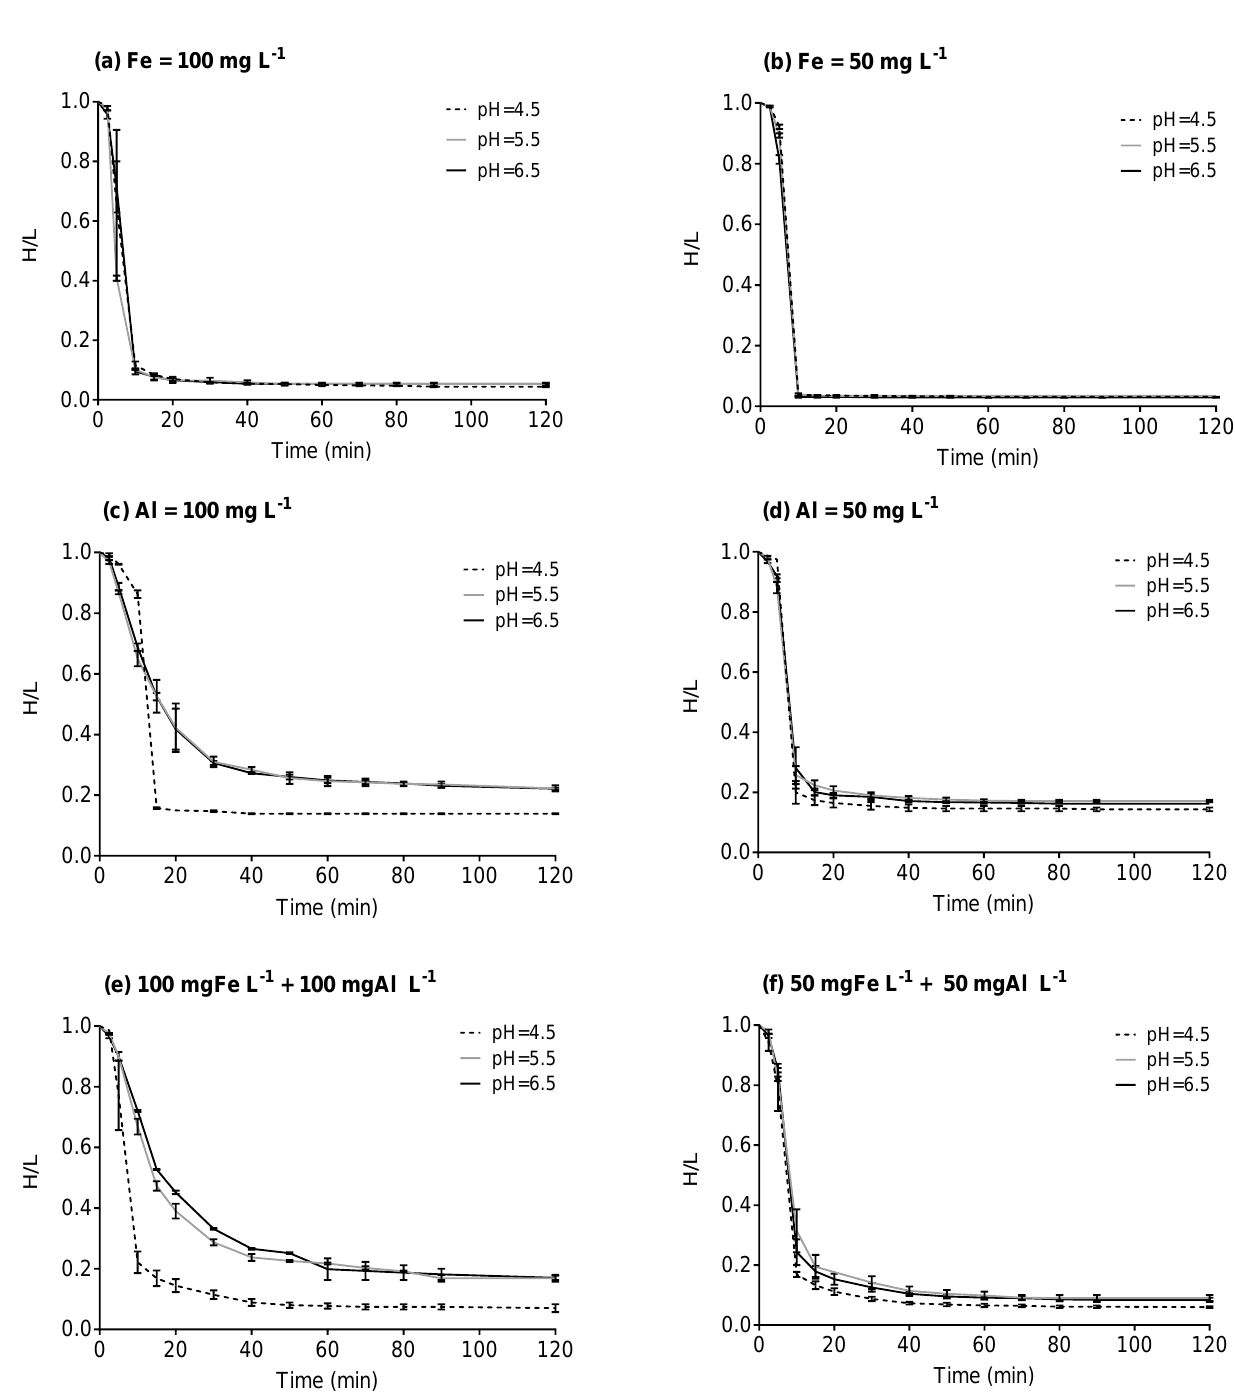
Figure 1. Floc phase-clarified phase settling height (H) of iron, aluminum, and iron+aluminum suspensions standardized by column height (L) (mean and range).